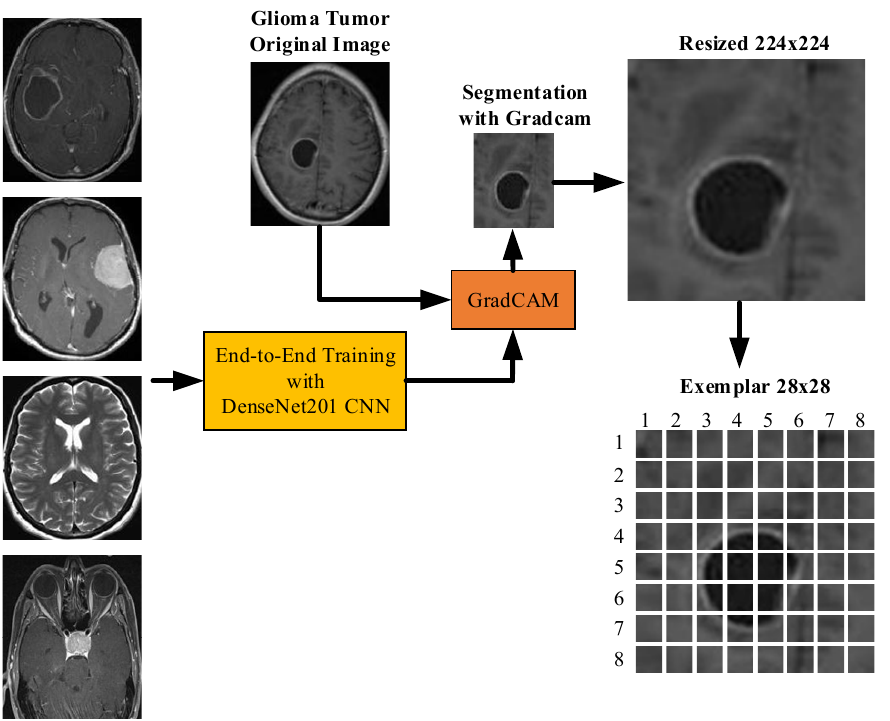
Figure 4. Illustration of preprocessing.